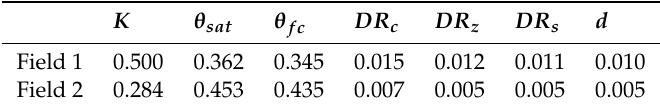
Table 3. Optimized parameters from the DE